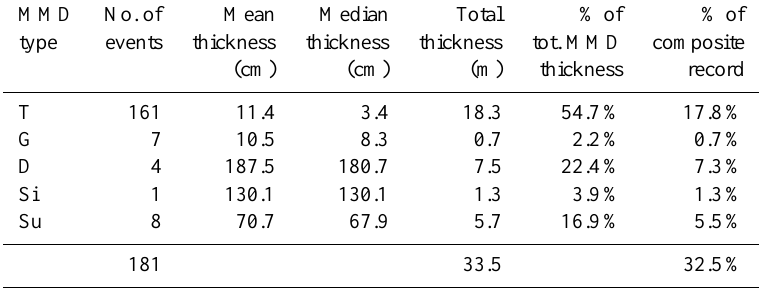
Table 2. A summary table of Pliocene MMDs in Lake El’gygytgyn (T=turbidite, G=grain-flow deposit, D=debrite, Si=slide, Su=slump). MMD No. of Mean Median Total % of % of type events thickness thickness thickness tot. MMD composite (cm) (cm) (m) thickness record T